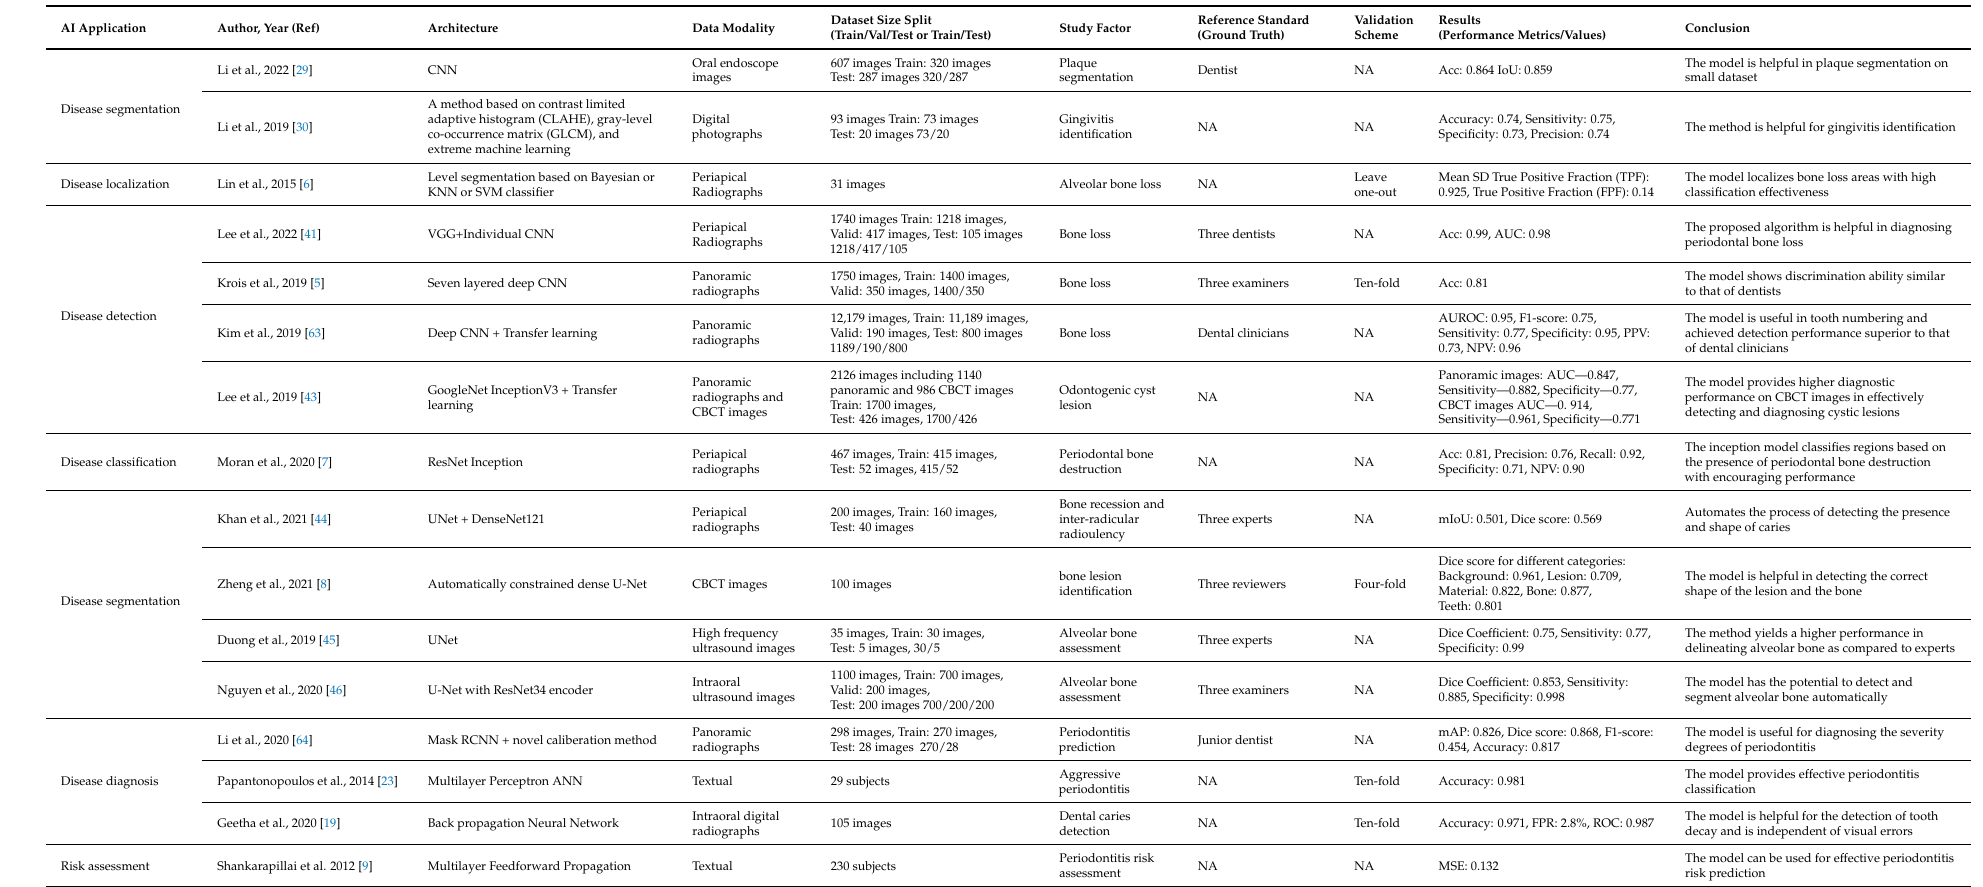
Table 3. Summary of related studies for AI application in